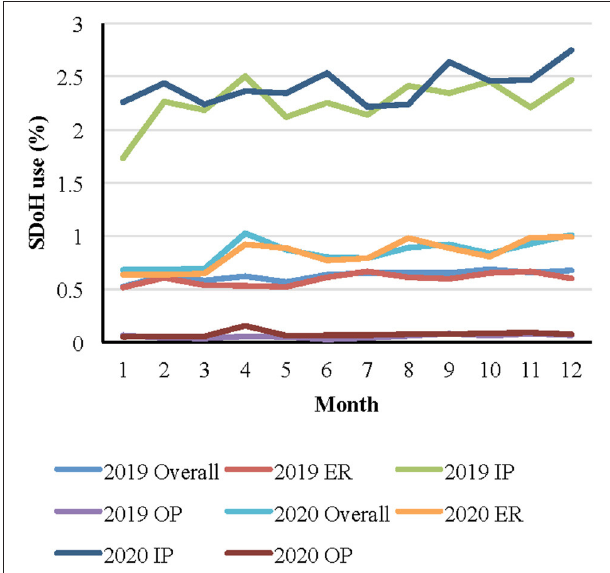
FIGURE 1 | Monthly Z code use by visit type over time * . * Note: ER = emergency room visit; IP = inpatient visit; OP = outpatient visit.